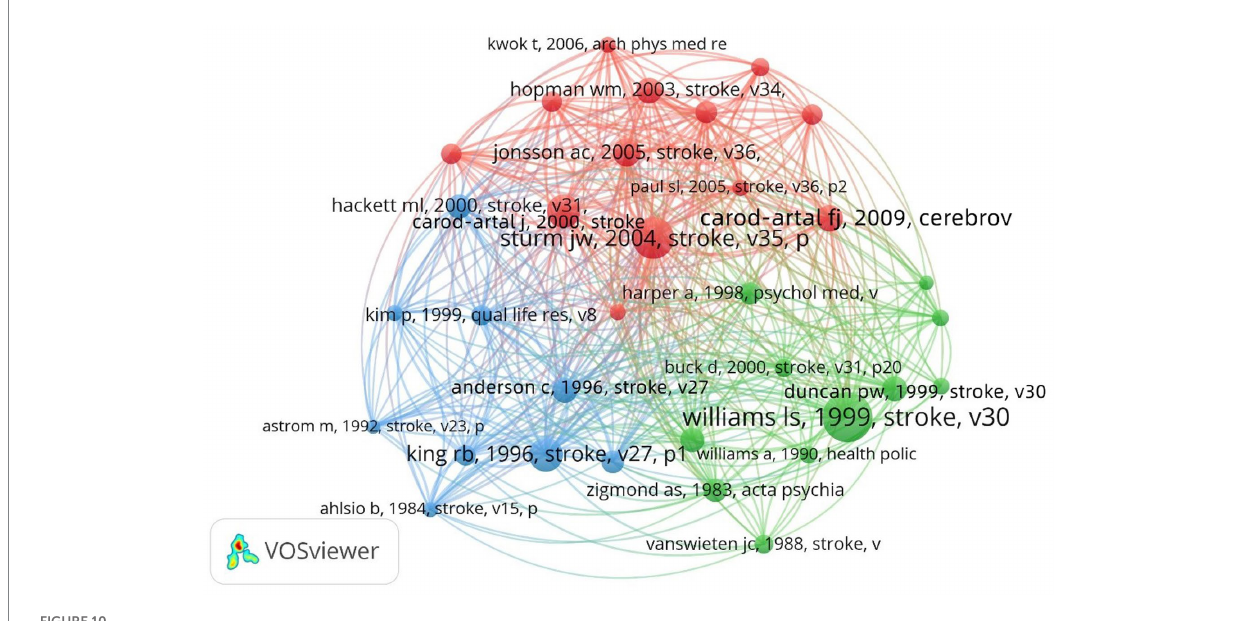
FIGURE 10 Map of co-cited references with